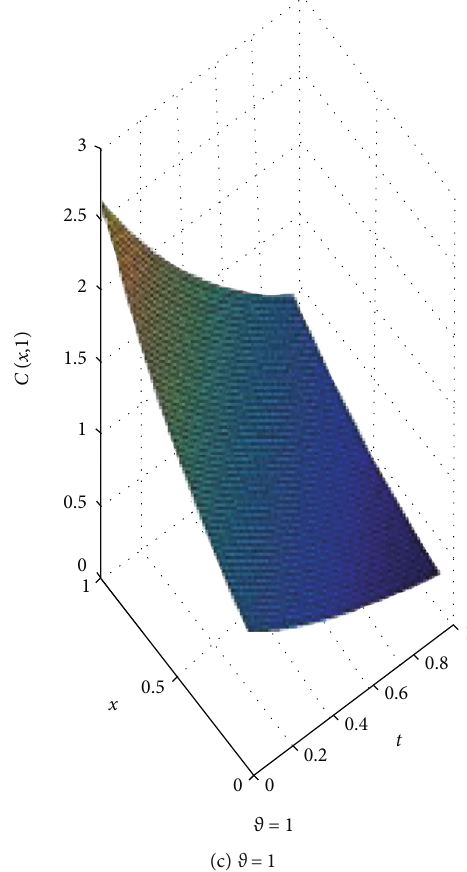
Figure 1: Variation of the concentration C ð x , t Þ with the fractional parameter α for μ = : 01